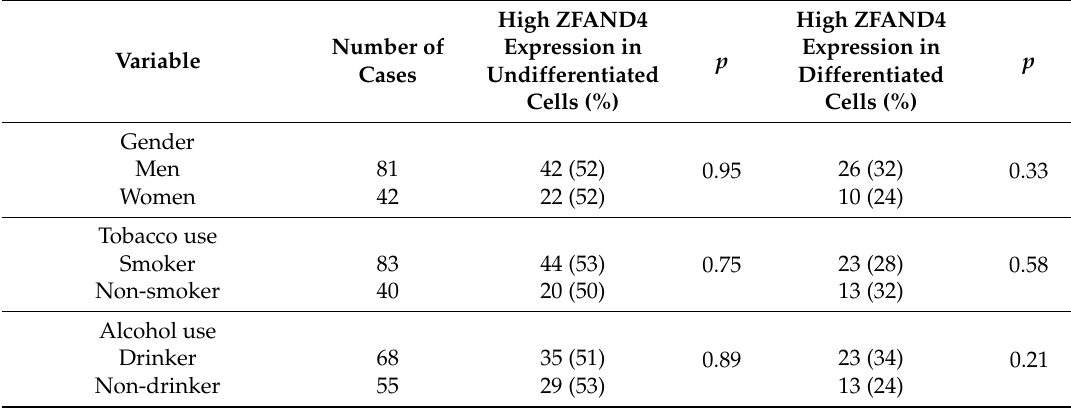
Table 3. Relationships between clinical and pathological variables and high ZFAND4 expression determined by using the mean value of stained cells to calculate the Allred